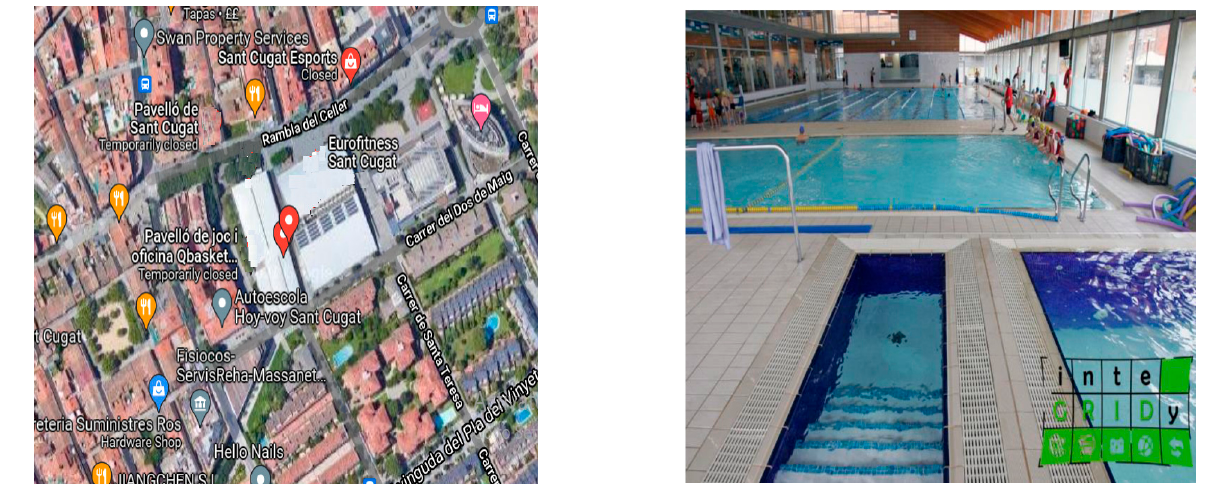
Figure 2. The location and actual picture of the demonstration pilot site, the sports Centre in Rambla del Celler, Barcelona.